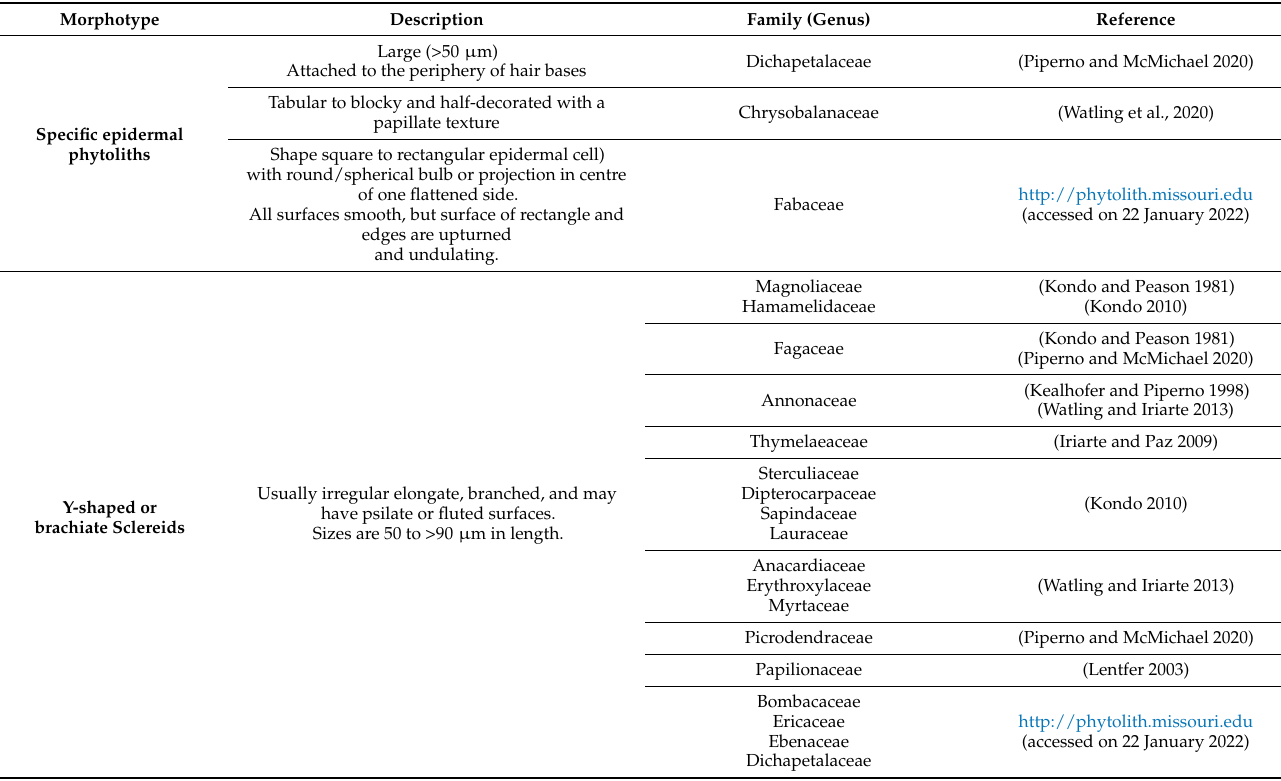
Table 1. Specific phytoliths produced in leaves of broad-leaf